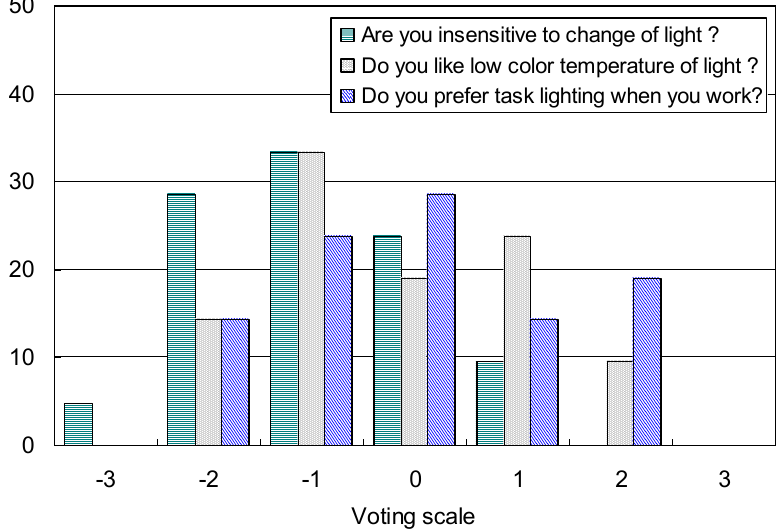
Figure 11. Subjects’ sensitivity and preference to indoor lighting